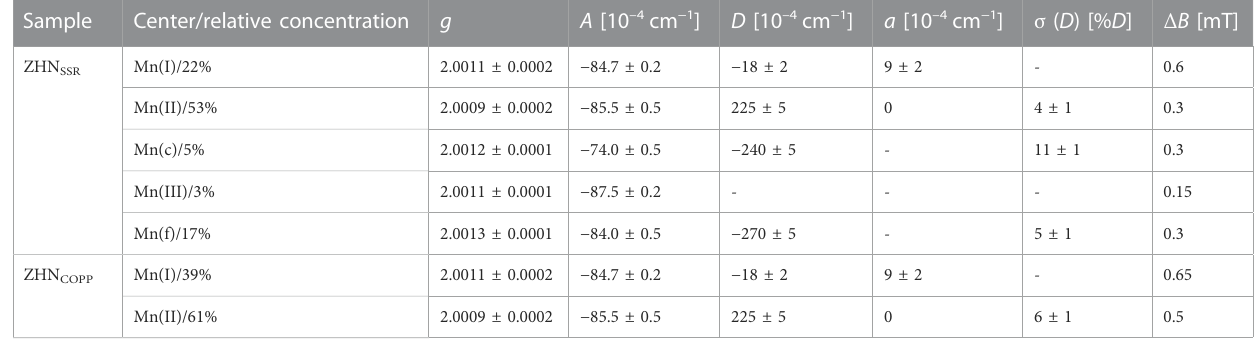
TABLE 2Relative concentration, EPR parameters ( g,A, D and a ), broadening parameter σ ( D ) andindividual peak-to-peak linewidth ( Δ B) of the Mn 2+ centers in the ZHN samples.